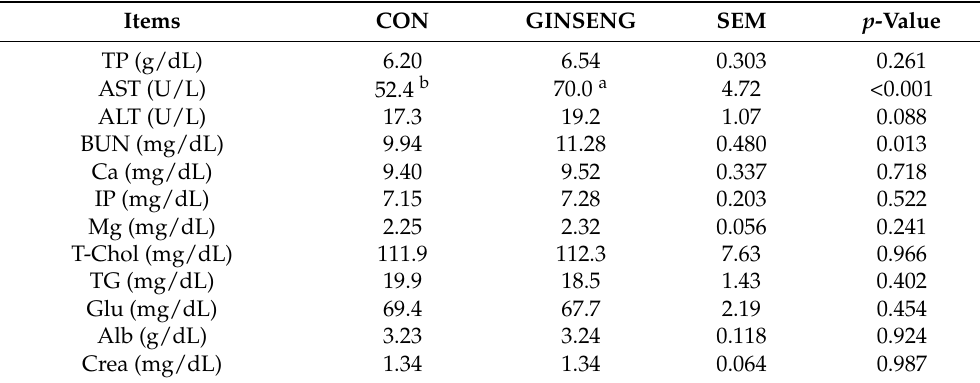
Table 7. Blood serum metabolites of heat-stressed Hanwoo steers supplemented with red gin- seng